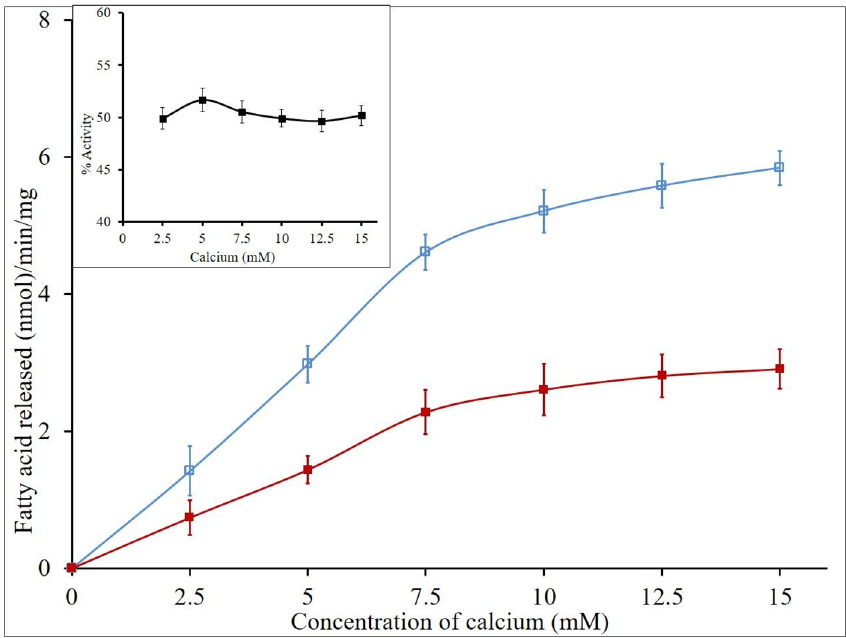
Figure 6. Effect of calcium concentration on inhibition of GIIA by elemolic acid. The reaction was performed with (red filled square) and without (blue open square) IC 50 concentration of elemolic acid and increased the Ca 2+ concentration from 2.5 to 15 mM. The GIIA inhibition was recorded in the presence of IC 50 concentration inhibitor and has shown inlet. The data are expressed in mean ± standard deviation (n = 3).